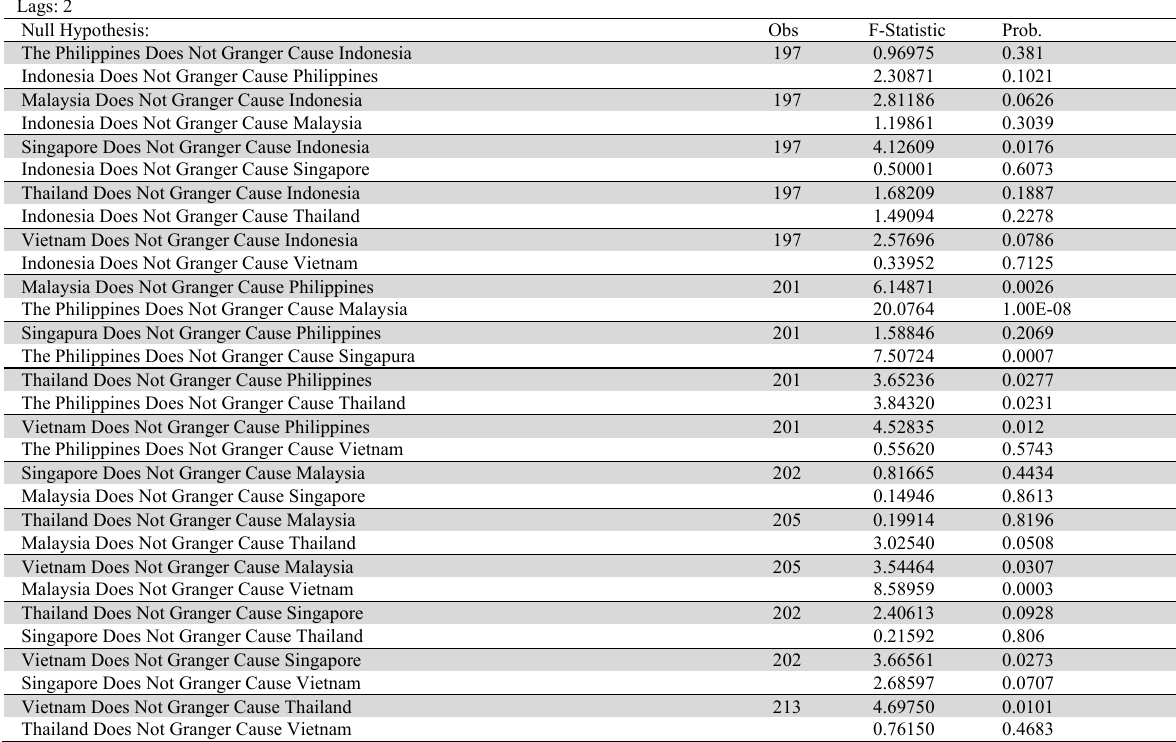
Granger causality test results Pairwise Granger Causality Tests Lags: